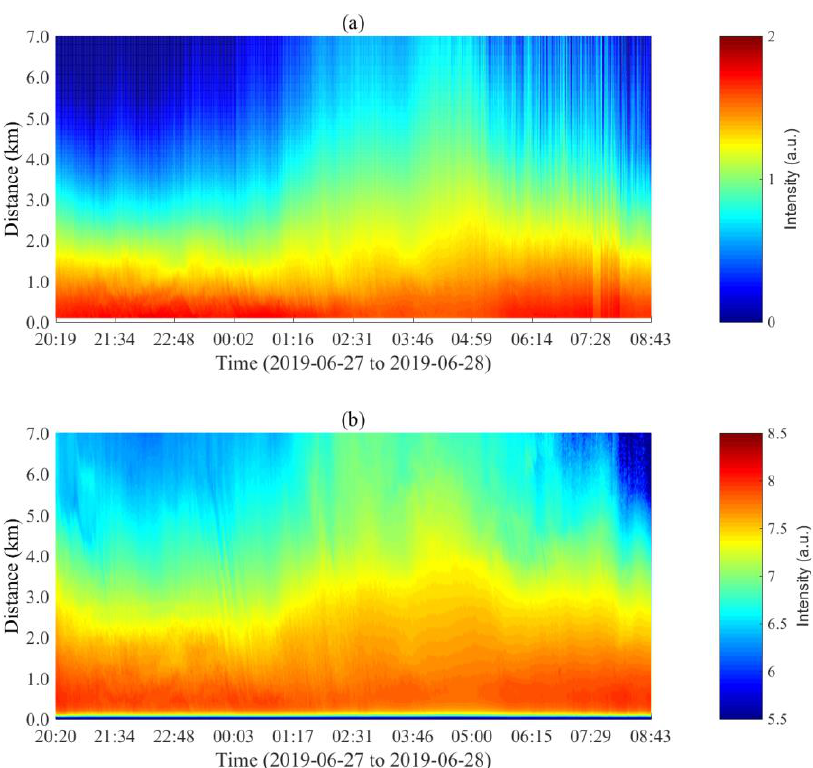
Figure 3. Atmospheric backscattering signals measured by ( a ) the SLidar system and ( b ) the pulsed lidar system from 27 June 2019 to 28 June 2019 (Local time) on a near horizontal path.